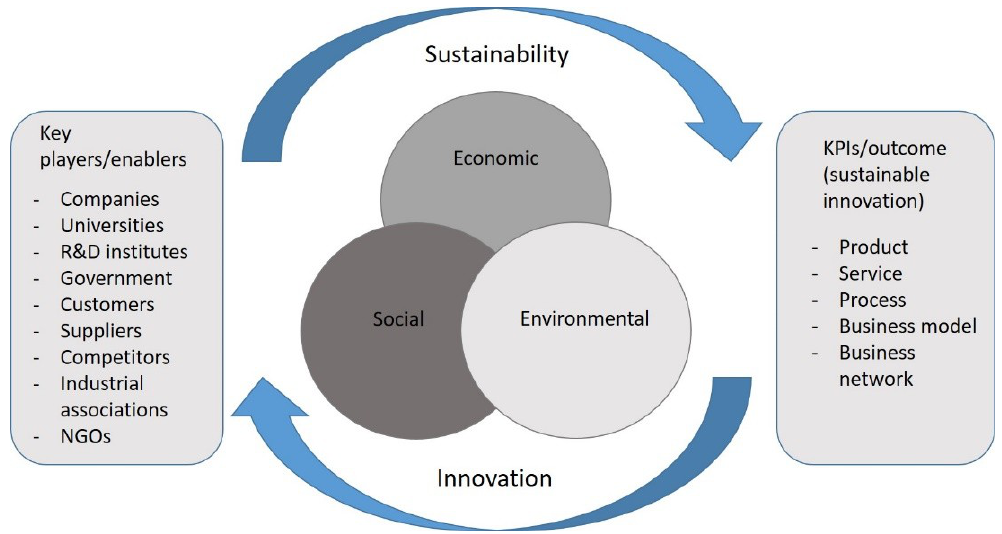
Figure 3. A conceptual framework of sustainable innovation.